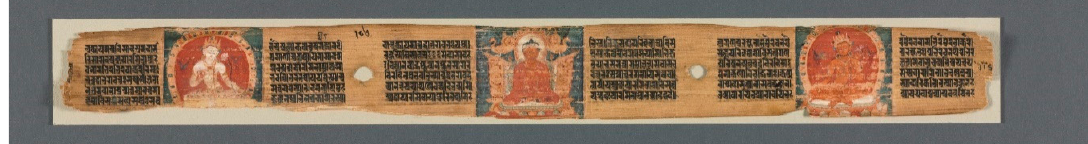
Figure 5. Prajñ ā p ā ramit ā flanked by a white female figure (left) and white bodhisattva (right), fol. 90r. Perfection of Wisdom in Eight Thousand Lines: A ṣṭ as ā hasrik ā Prajñ ā p ā ramit ā -s ū tra , 1119. India and Nepal. Gum tempera and ink on palm leaf. 6.1 × 55.8 cm. Cleveland Museum of Art, purchase from the J. H. Wade Fund, 1938.301.3.